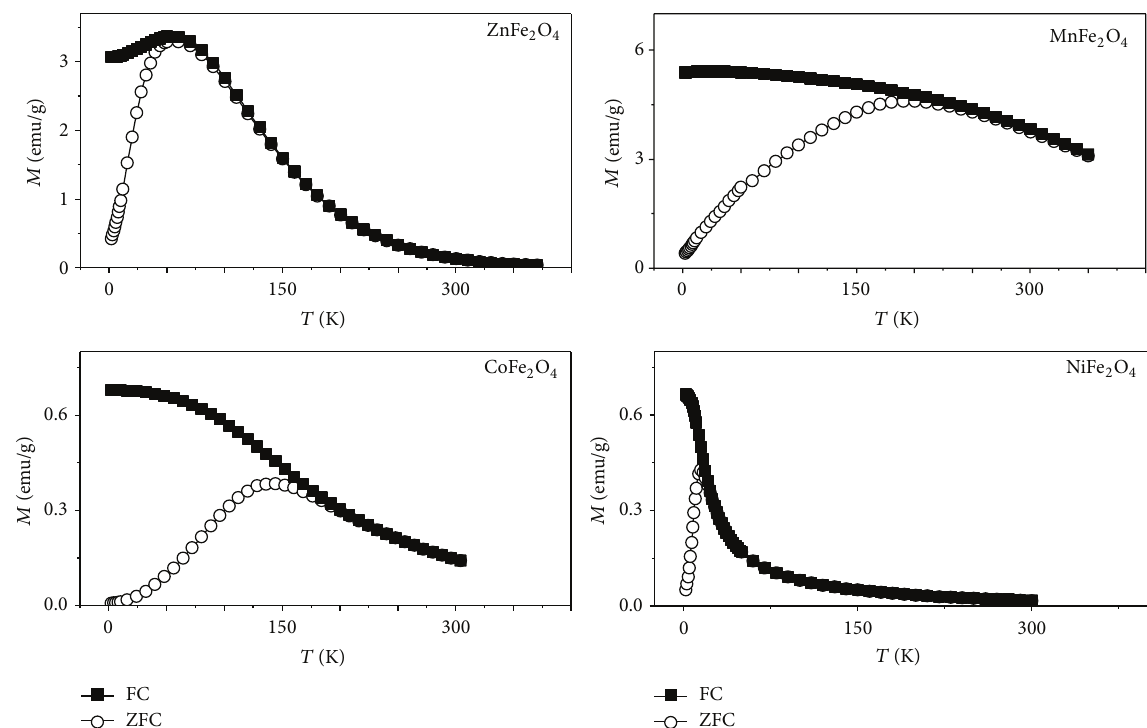
Figure 5: Temperature dependences of magnetization 𝑀 (ZFC- and FC-measurements) for the NPs of zinc, manganese, cobalt, and nickel spinel ferrites. Measurements were carried out in magnetic field 𝐻